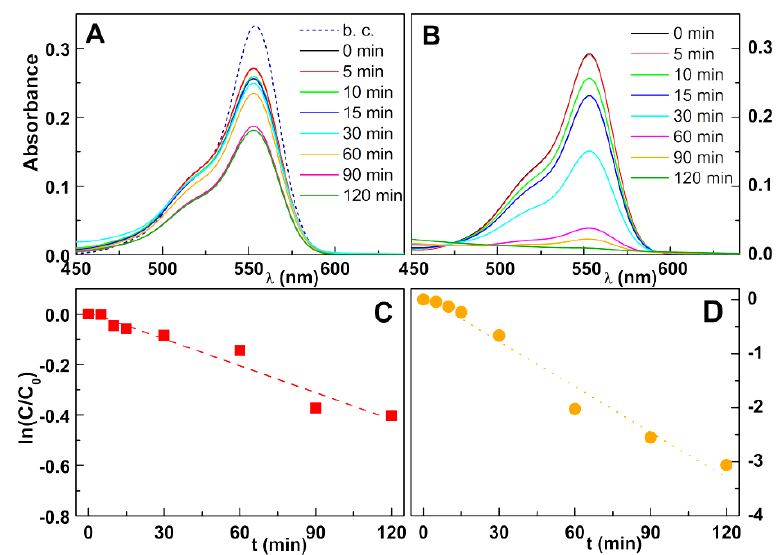
Table 3. Rate of degradation of the dyes in a pseudo-first-order kinetics. Figure 6. ( A , B ): Photodegradation assays of solutions of the dye Rhodamine B (40 mg/L) by zinc/calcium ferrite nanoparticles covered with silver by photodeposition. b. c.: Dye absorption spectrum before adding the catalyst; ( A ): Ferrites prepared by co-precipitation; ( B ) : Ferrites prepared by sol–gel. ( C,D ) : Plot of the pseudo-first-order kinetics for degradation of Rhodamine B; ( C ): Ferrites prepared by co-precipitation; ( D ) : Ferrites prepared by sol–gel.